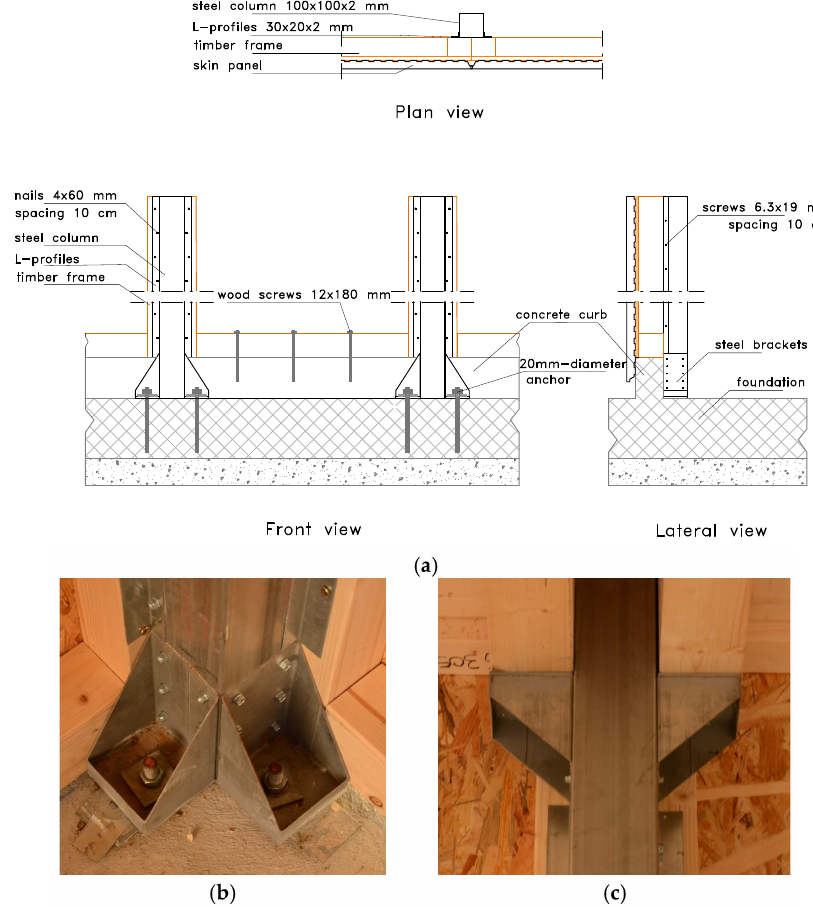
Figure 3. Steel column and brackets: ( a ) Geometric details of connection with foundation (dimensions in mm); ( b ) Connection with the foundation; and ( c ) Connection with the roof.